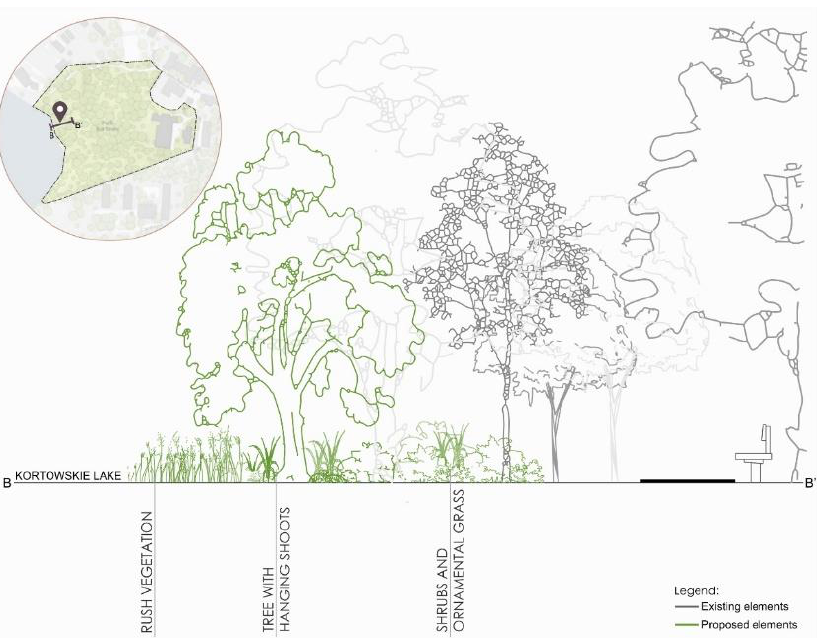
Figure 10. Scheme for re-design of the B zone in Kortowo park.